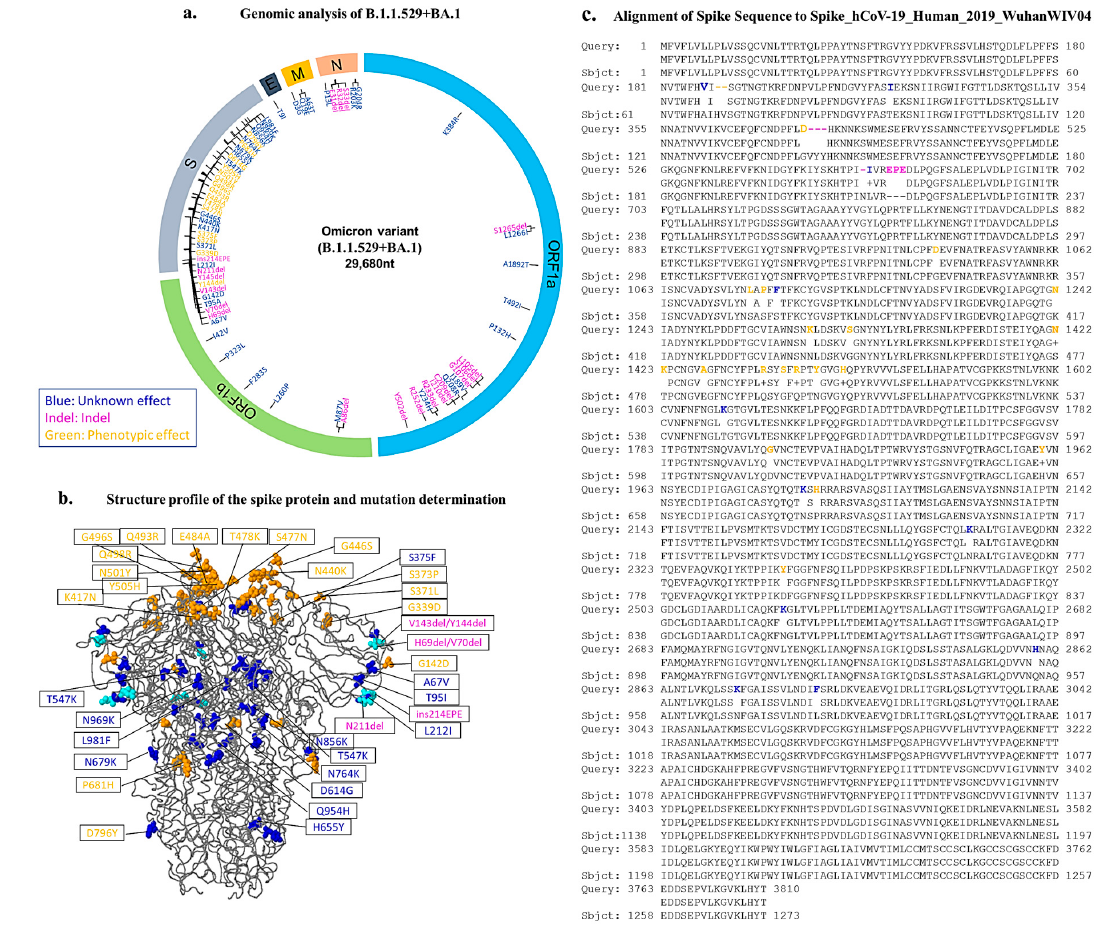
Figure 1. Full-length genome structure of the IKR Omicron variant (B.1.1.529 + BA.1). ( a ) The whole-genome map showed the regions (including ORF1a, ORF 1b and S = spike protein, E = envelope, M = membrane and N = nucleocapsid) and the location of 68 mutations, including deletion, insertion and substitutions. ( b ) The spike protein structure revealed 35 alterations in the subunits of S1, S1/S2 and S2. ( c ) Spike protein sequence which showed the location of amino acid changes, including deletion, insertion and substitutions was aligned to the spike protein sequence of Spike_hCoV ‐